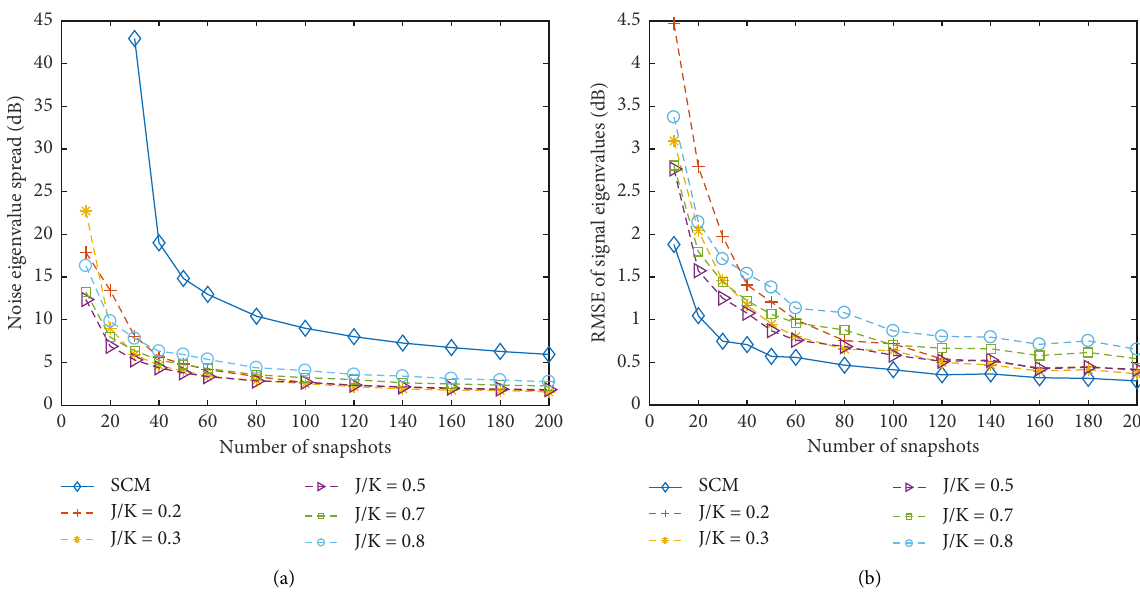
Figure 1: Estimation performance of different choices of J versus number of snapshots under case (i), (SNR � 20dB, Q � 4) (a) Noise eigenvalue spread. (b) Signal eigenvalue RMSE.